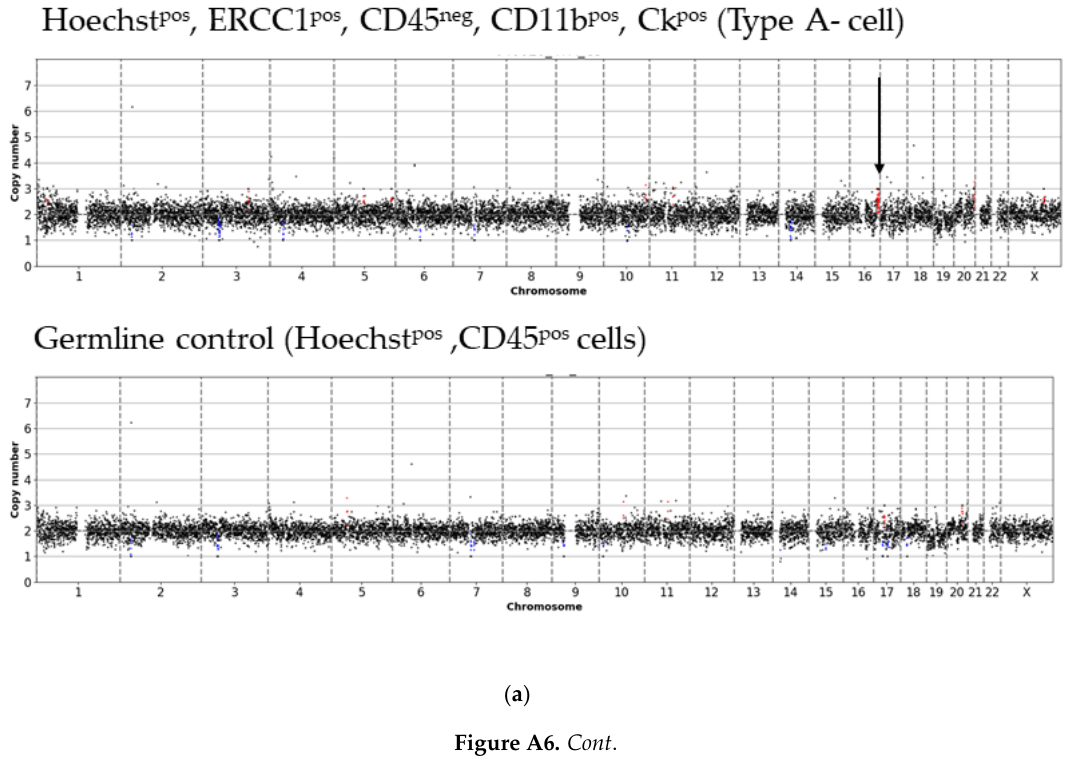
with a ploidy of 2 from Patient 12. ( g ) Other cell type (Hoechst pos , ERCC1 neg , CD45 neg , CD11b pos , CK pos ) with matched CN profile with a ploidy of 5 from patient 11.